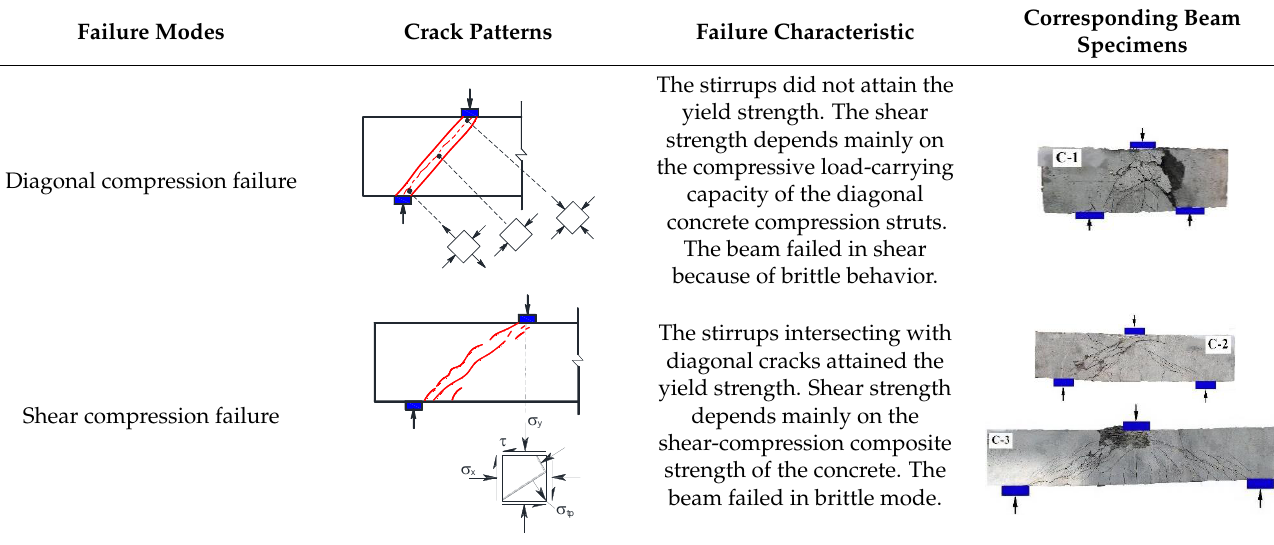
Table 7. Crack patterns and failure modes of RHDC beams.